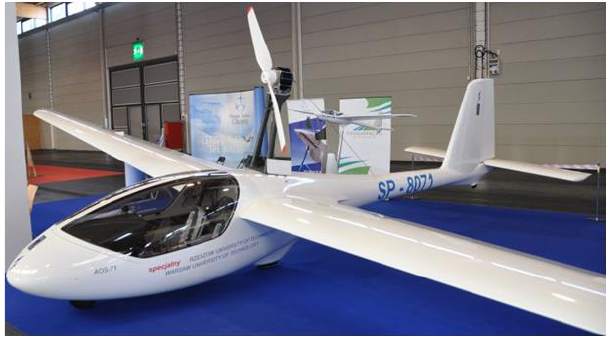
Fig. 5. The AOS 71 motor glider 71 [35]